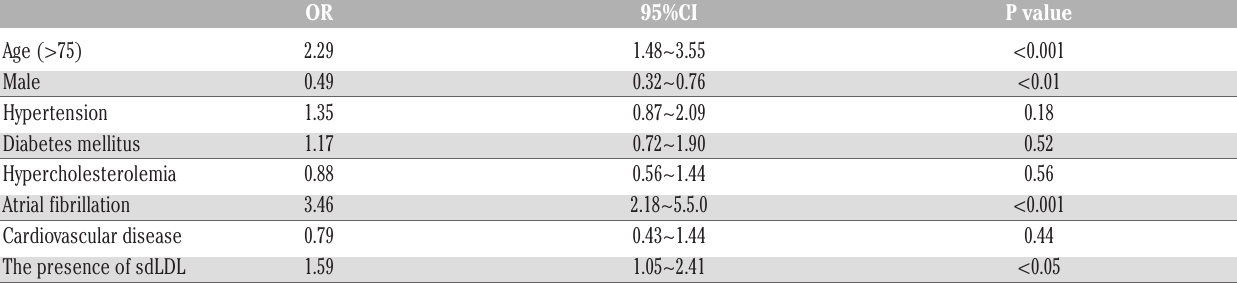
Table 3. Odds ratio for an association of risk factors with poor